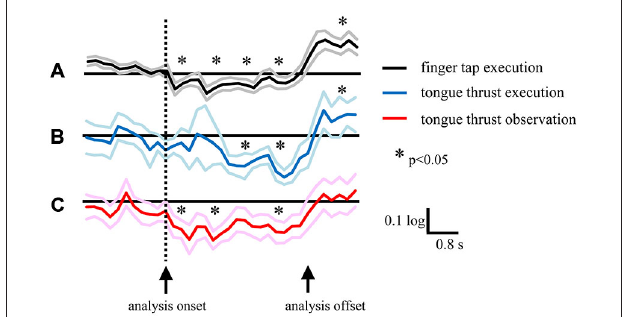
FIGURE 7 | Grand average of logarithmic EEG power ratios for the beta band in the left hemisphere during right finger tap execution (A), mu band during leftward tongue thrust execution (B), and mu band during leftward tongue thrust observation (C) . Black, blue, and red lines indicate mean. Gray, light blue, and pink lines indicate plus or minus one standard error. ∗ p <